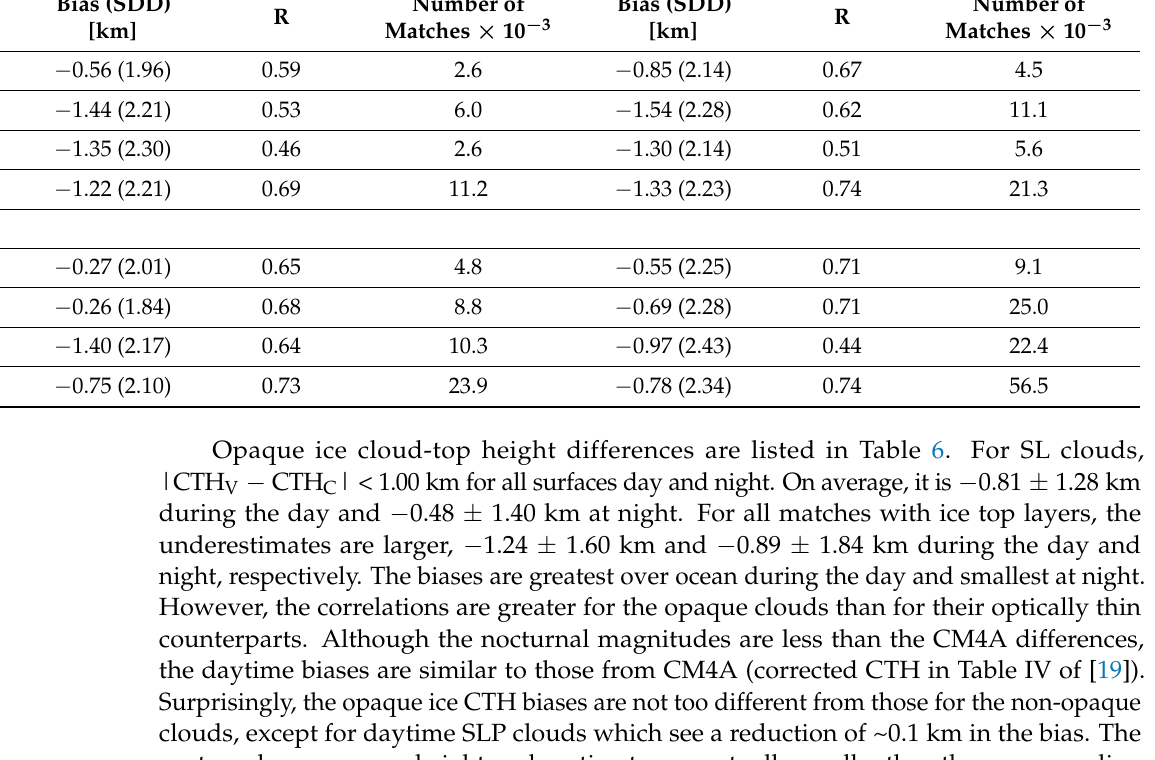
Table 5. Differences, SNPP VIIRS Ed1 − CALIPSO, cloud top heights for non-opaque ice clouds, JAJO 2015 and 2016. Single Layer Ice Only All with Ice